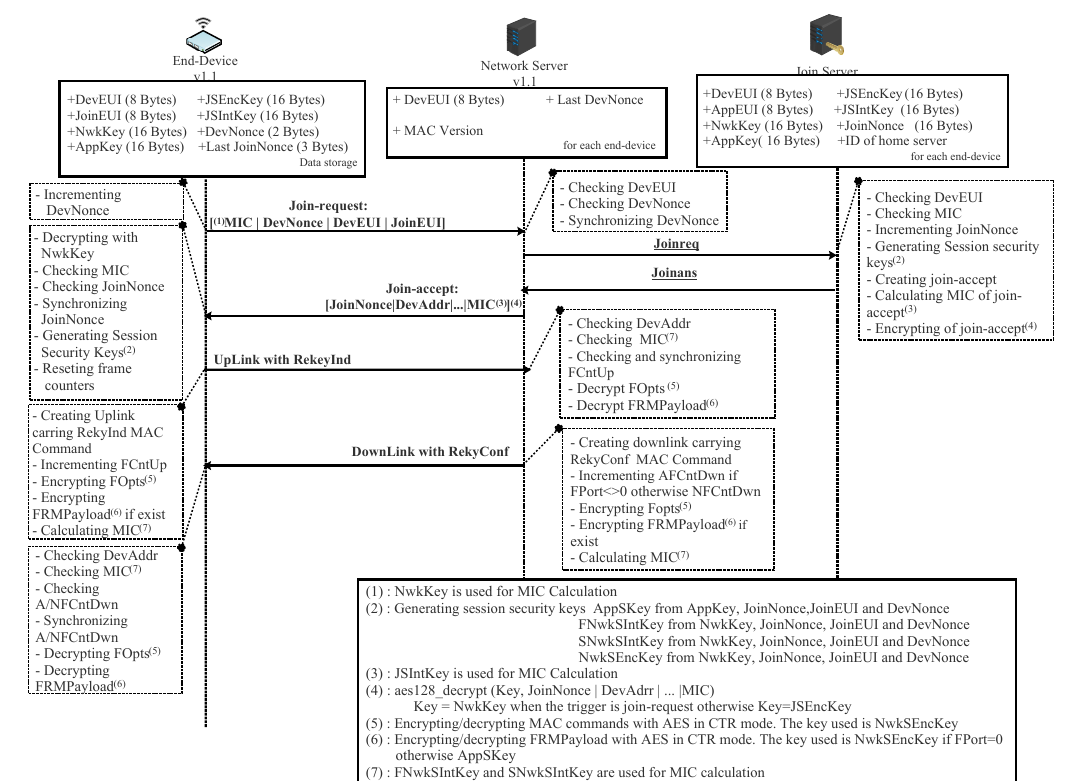
Figure 9. OTA-ED v1.1 joining NS v1.1 in scenario